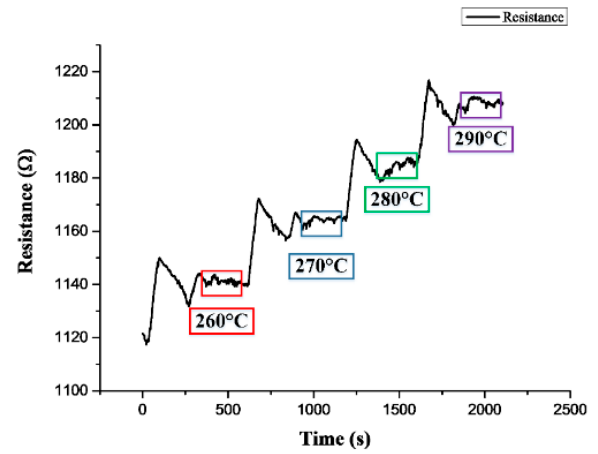
Figure 9. Real-time micro-monitoring of hydrogen desorption temperature and strain of hydrogen storage tank.